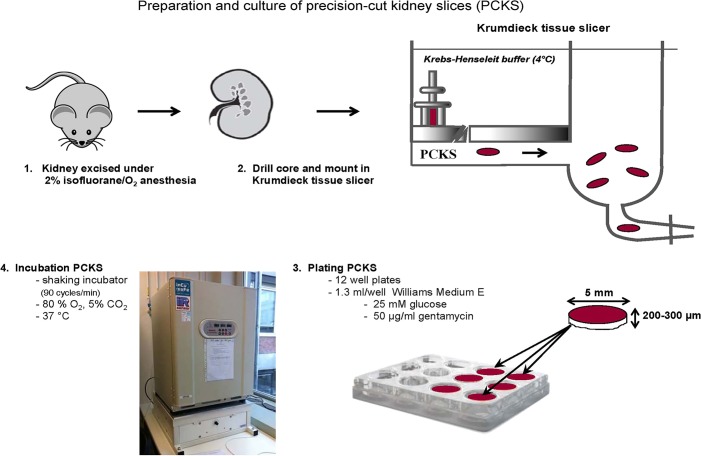
Schematic representation of the experimental approach for obtaining and culturing mPCKS. (1) Mouse kidneys (n=3) were excised under isofluorane/O2 anesthesia and placed into ice-cold UW preservation solution. (2) Cores were drilled and immediately transferred to the cylindrical core holder of a Krumdieck slicer and cut into 5-mm diameter slices. (3) High-quality slices (equal thickness at all sides and smooth edges) were transferred to 12-well plates using a spatula to avoid damaging of the slices, and (4) were placed in a shaking (90 cycles/min) incubator under continuous supply of 80% O2/5% CO2 at 37°C.